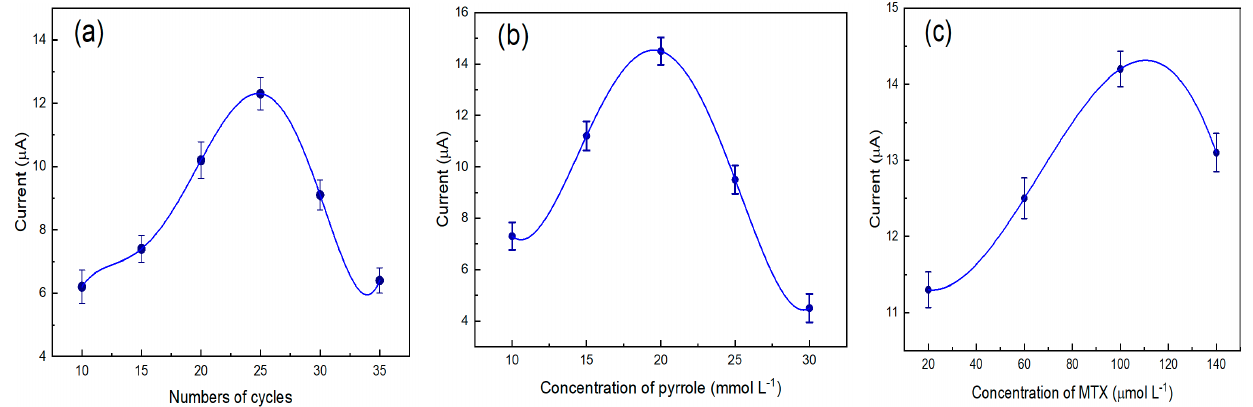
Figure 5. Effects of electropolymerization of pyrrole on MWCNT/GCE: Number of cycles ( a ), the concentration of pyrrole ( b ), and concentration of methotrexate ( c ).